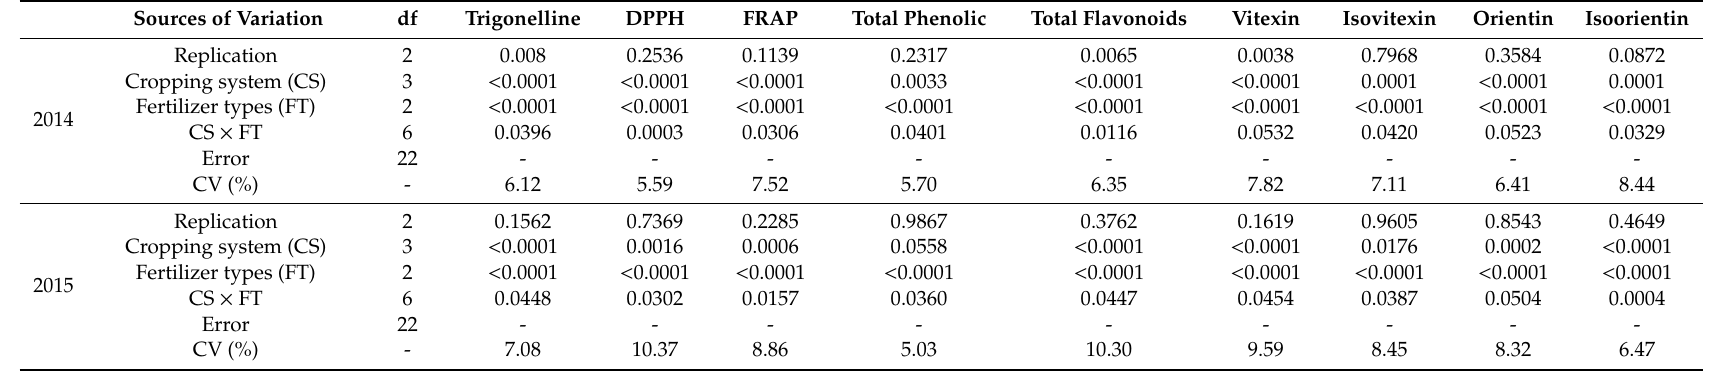
Table 1. ANOVA results ( p -values) for trigonelline, antioxidant activity estimated by 2,2-Diphenyl-1-Picrylhydrazyl (DPPH) and Ferric reducing antioxidant power (FRAP) assay, total phenolic, total flavonoids, vitexin, isovitexin, orientin, and isoorientin content of fenugreek seeds in 2014 and